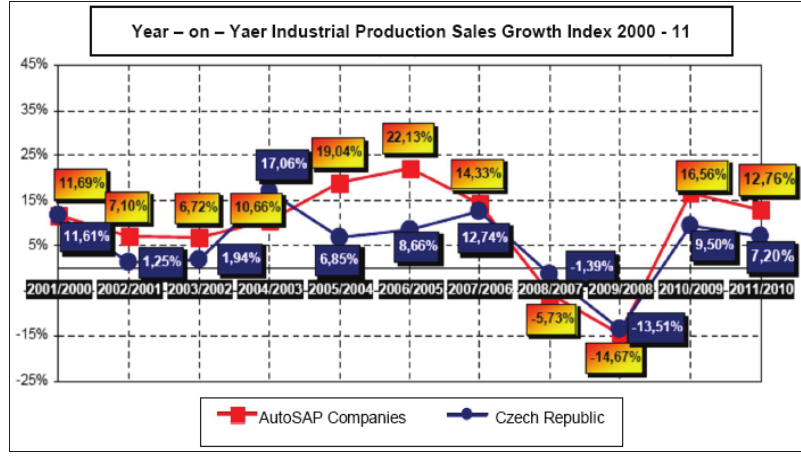
Fig. 4 – Year-on-Year Industrial Production Sales Growth Index. Source: AutoSAP,